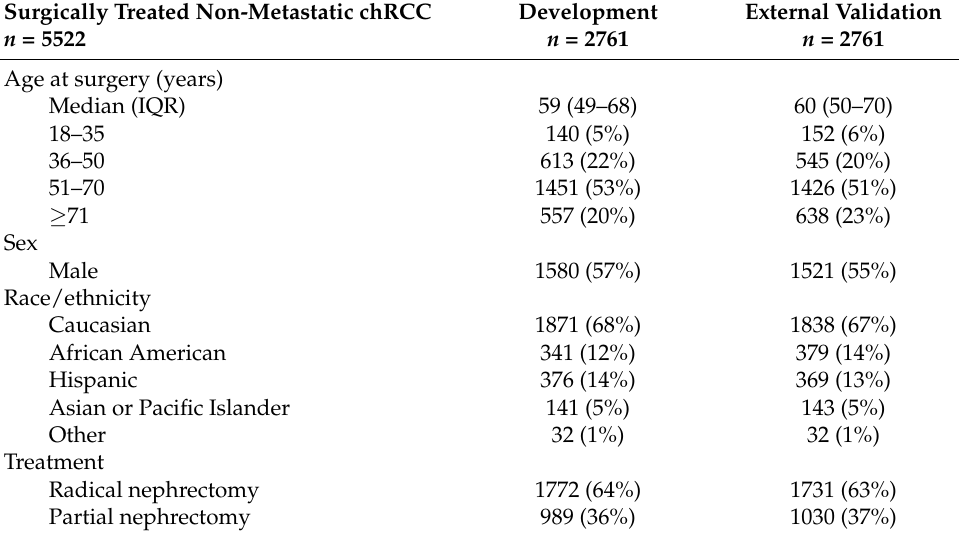
Table 1. Descriptive characteristics of patients diagnosed with surgically treated unilateral non- metastatic chromophobe renal carcinoma between 2000 and 2019 in the Surveillance, Epidemiology, and End Results database. The overall cohort was randomly divided into a development (50%) and an external validation (50%) cohort. chRCC: chromophobe renal cell